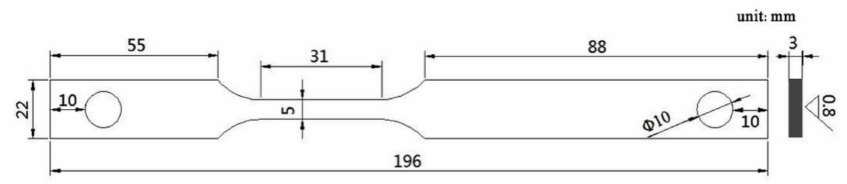
Figure 1. Drawing of the tensile specimen with slow strain